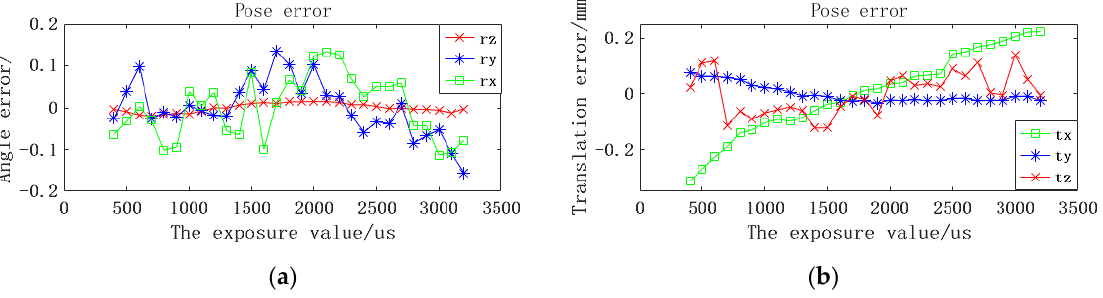
Figure 12. Positioning errors under different brightness conditions. ( a ) Rotational errors on the x, y, and z axes. ( b ) Translation errors on the x, y, and z axes.